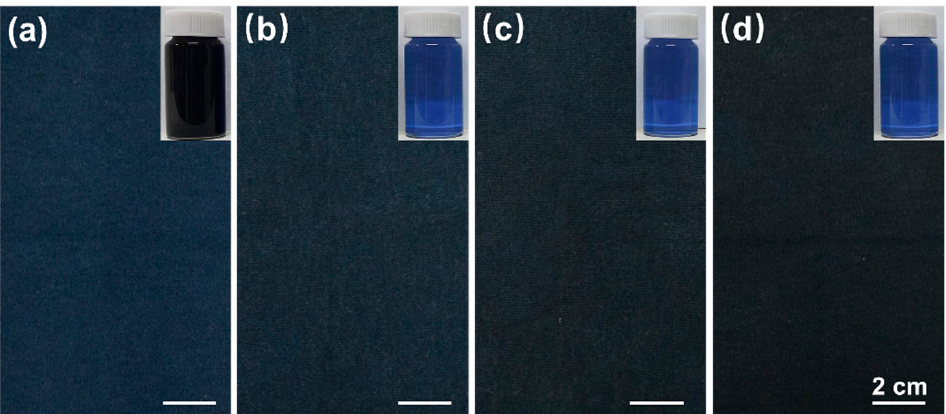
Figure 9. Comparison of the different dyed samples: ( a ) NC, ( b ) NCC, ( c ) PCC(EtOH-70), and ( d ) PCC(NPA-60), and the corresponding dyeing residues.